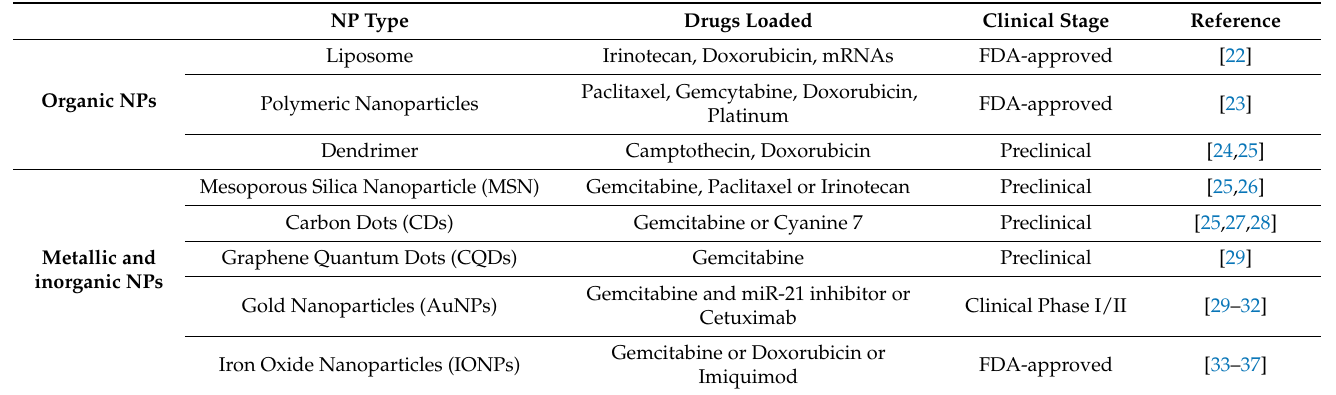
Table 1. Clinical organic and inorganic nanoparticles designed for cancer imaging or therapy.